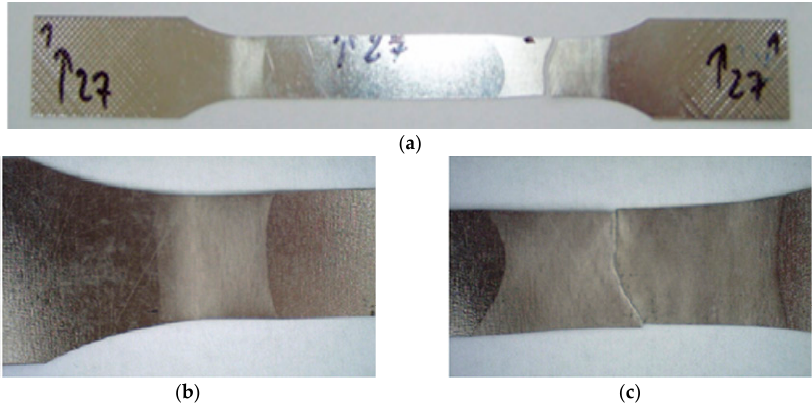
Figure 6. The specimen after uniaxial tensile test: ( a ) local deformation at two places with the fracture; ( b ) detail of a locally deformed material after plastic deformation without fracture; ( c ) detail of a local deformation with the fracture.